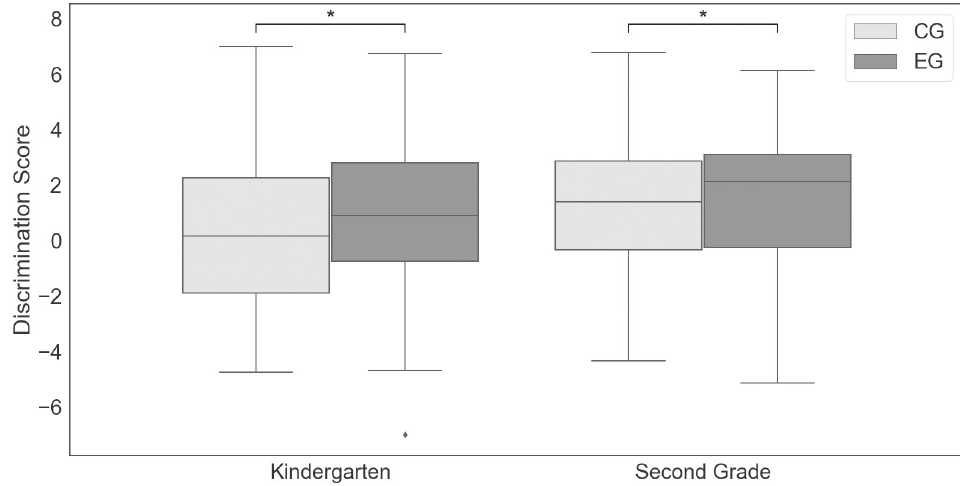
Fig 1. Distribution of the discrimination score separated for condition and age. Note. Boxplot for the dependent variable discrimination score, separated for Age (Kindergartners vs. Second Graders), and Condition (Control Group (CG) vs. Experimental Group (EG)). Whiskers represent 1.5 � interquartile range.